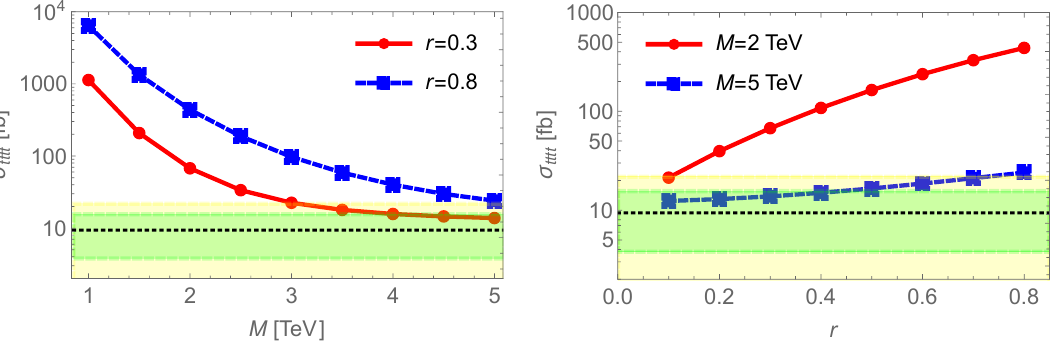
Figure 14 . The total cross-section pp → tt ¯ t ¯ t as a function of the renormalized on-shell mass M (left panel) for the fixed ratios r = 0 . 3 (red solid line) and r = 0 . 8 (blue dashed line), and as a function of the ratio r (right panel) for the fixed masses M = 2 TeV (red solid line) and M = 5 TeV (blue dashed line). The different lines correspond to the predictions based on the full propagator (pole approach), while the bands represent 1 σ (light green) and 2 σ (light yellow) deviations from the σ obs central value (black dotted line) observed by the CMS collaboration [24]. tt ¯ t ¯ t of r for M = 2 TeV (red solid line) and M = 5 TeV (blue dashed line). Clearly, a